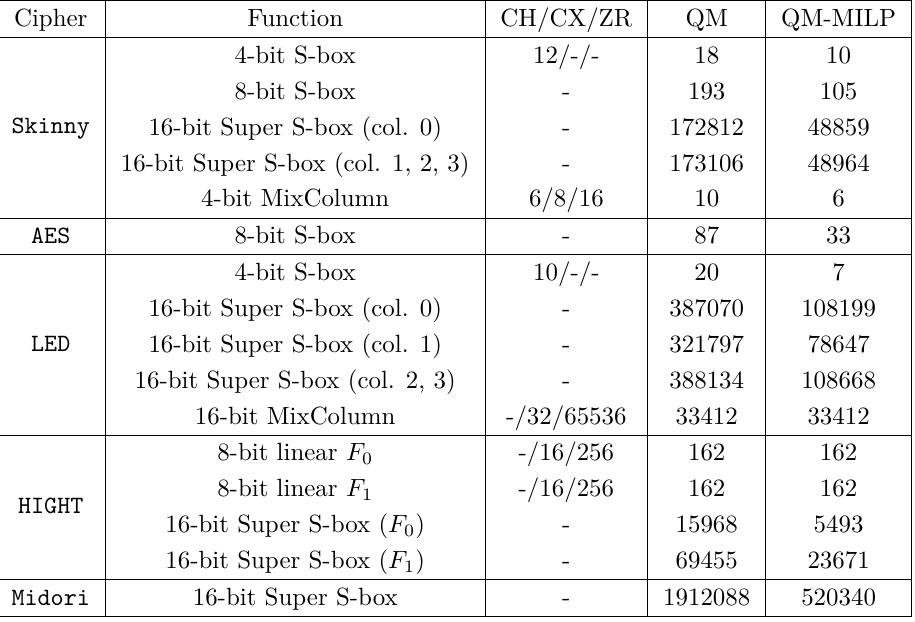
Table 2: Number of inequalities required to describe valid transitions. Note that the Copy-Xor technique is lossy and does add extra